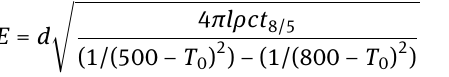
Figure 1. The specimens were heated to 1350 ∘ C at 100 ∘ C/s, and then held for 1 s. The t was chosen as 30, 60, 90, 120 8/5 and 180 s to simulate different welding heat input which was equivalent to that in-service welding of 30.5, 43.2, 52.9, 61.1and74.8kJ/cm,respectively,basedontheircorrelation exhibited as Eq. 3